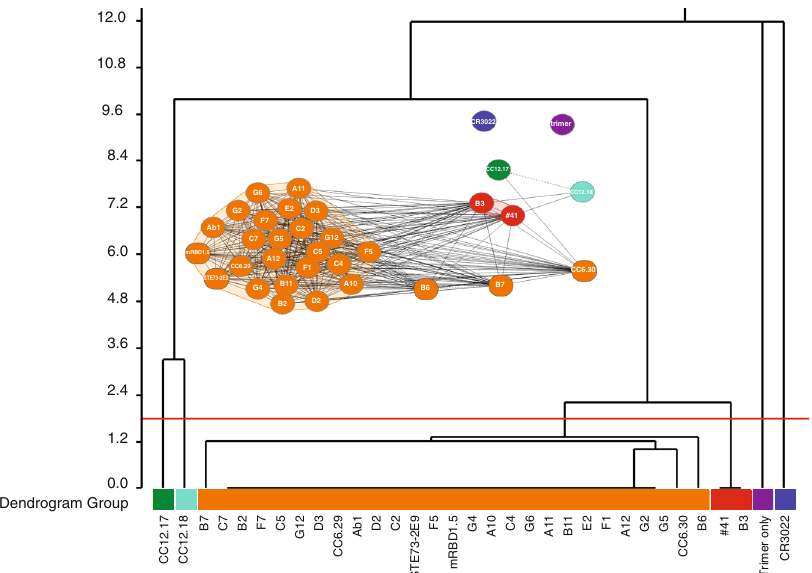
Fig. 3 Binning of discovered leads. Advanced binary dendrogram of each of the antibodies in a pairwise manner. Most of the selected antibodies belong to the RBD-A epitope group, reported as the one with highest neutralization potency. Table 1 Neutralization potencies of the selected antibodies obtained from the pseudovirus